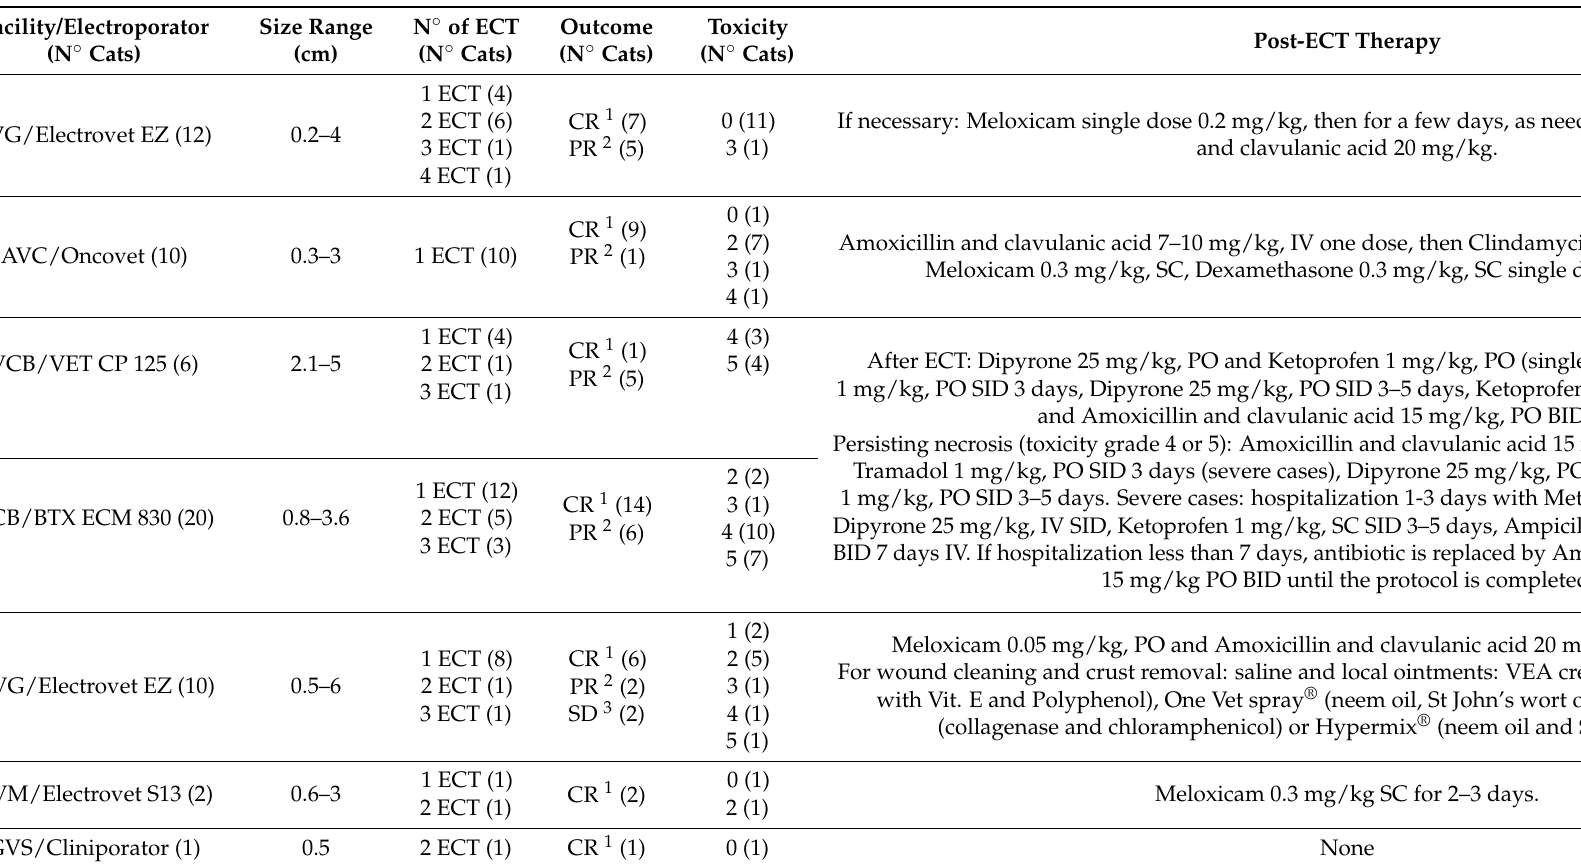
Table 2. Facility enrolled, tumor size range and, for each cat, the number of ECT treatments received, the local treatment response and the toxicity along with the post-ECT therapy.